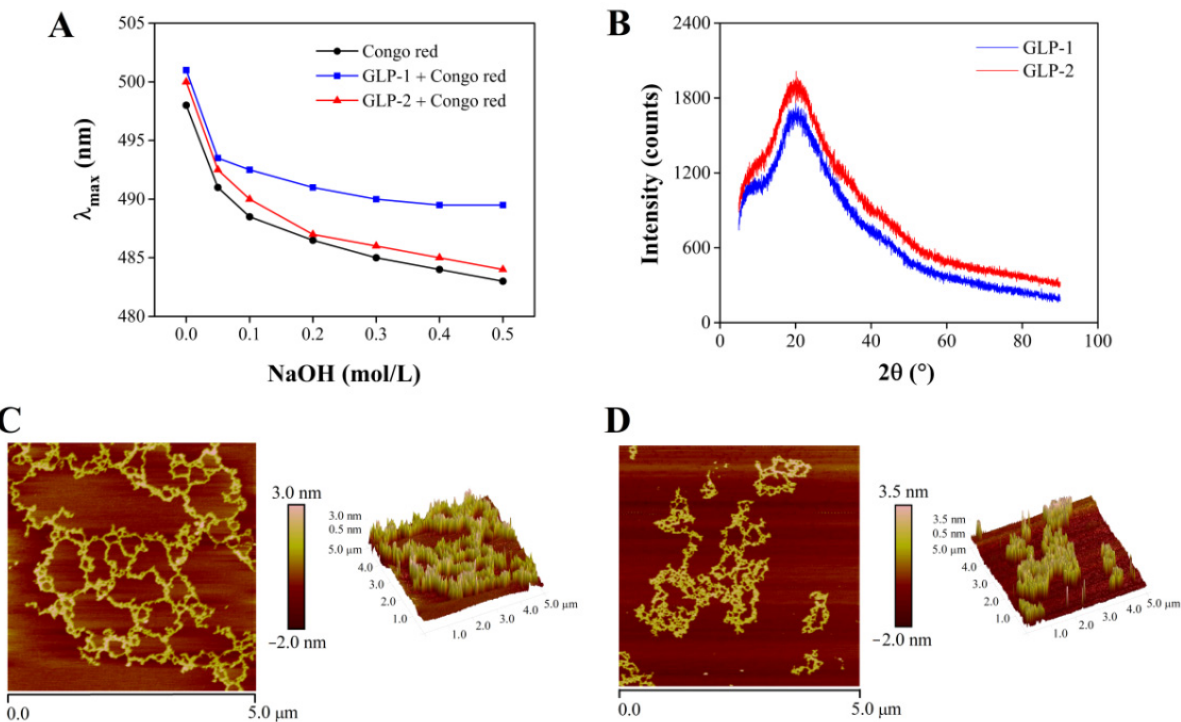
Figure 3. Maximum absorption wavelength of Congo red–polysaccharide complex and Congo red at different NaOH concentrations ( A ). XRD analysis results of GLP-1 and GLP-2 ( B ). AFM planar and cubic images of GLP-1 (scan size: 5 μ m) ( C ). AFM planar and cubic images of GLP-2 (scan size: 5 μ m) ( D ).